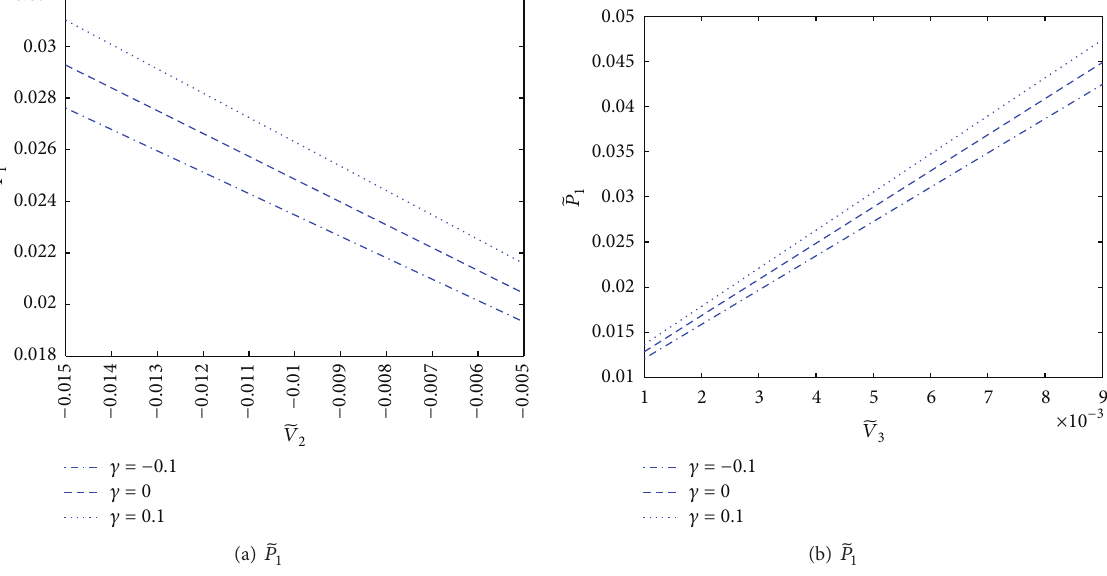
̃𝑃 1 with respect to the group parameters